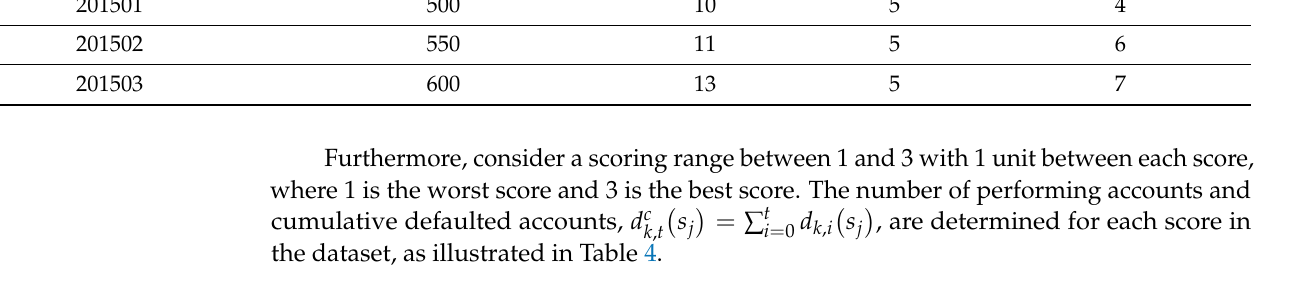
Table 4. Data construction for Lorenz